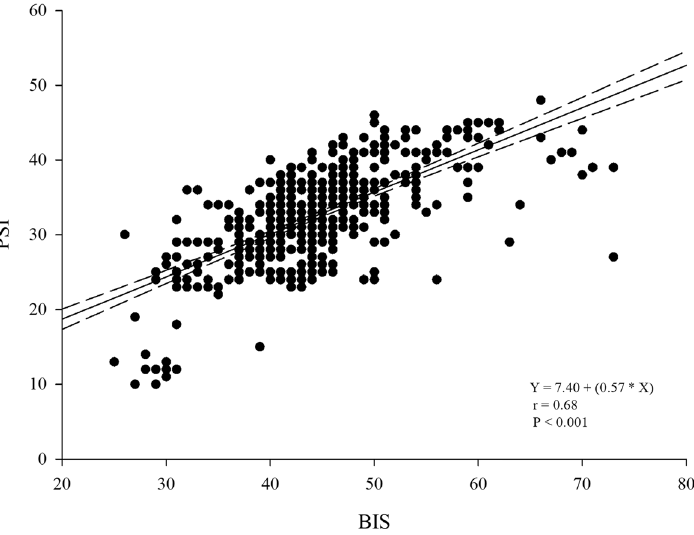
Figure 3. Correlation between bispectral index (BIS) and patient state index (PSI) values simultaneously recorded during 10 min after sugammadex administration.